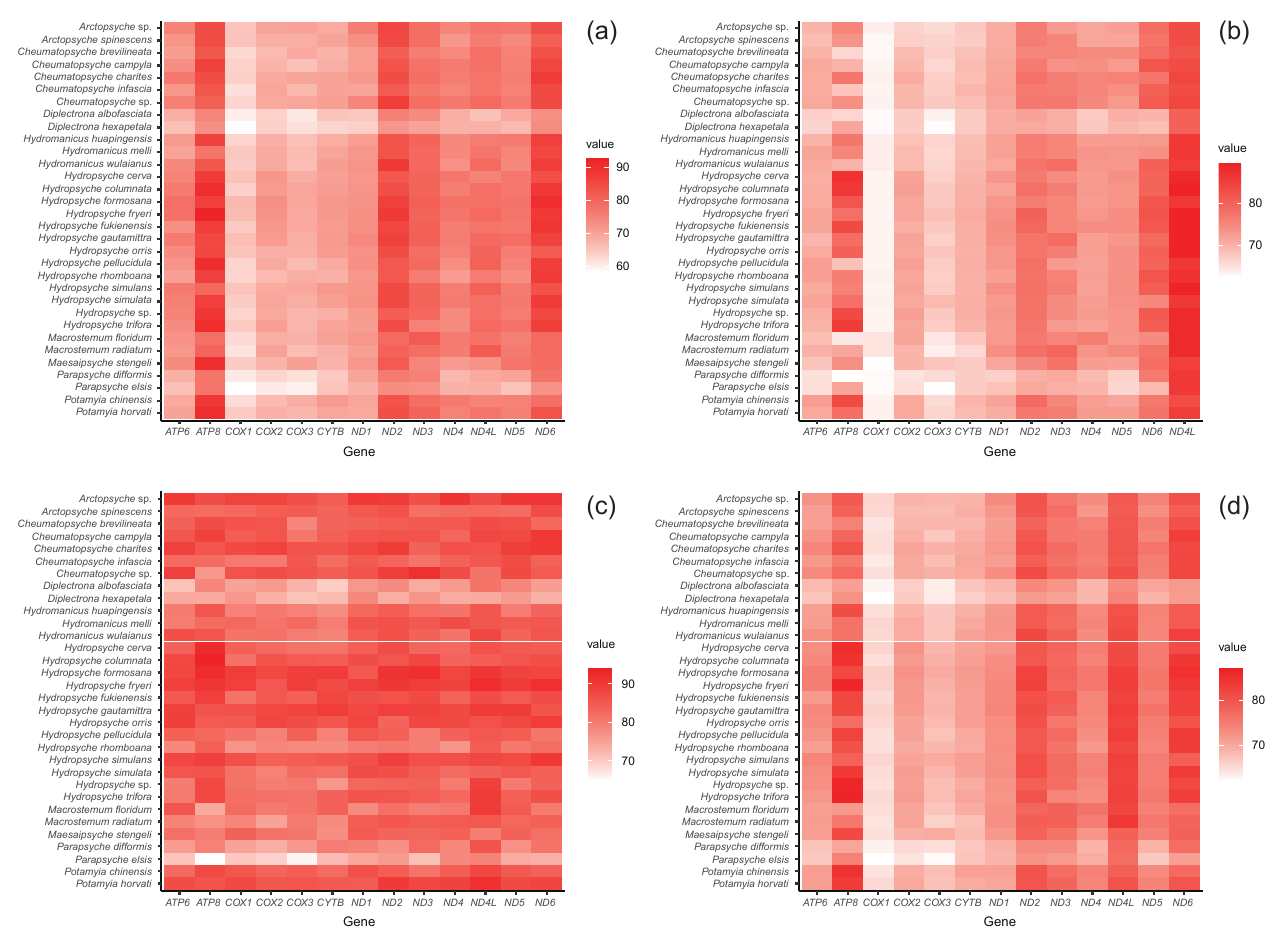
Figure 2. A+T content of protein-coding gene of hydropsychid mitogenomes for different codon positions. The value increases from white to red. ( a ) First codon positions; ( b ) second codon positions; ( c ) third codon positions; ( d ) first/second codon